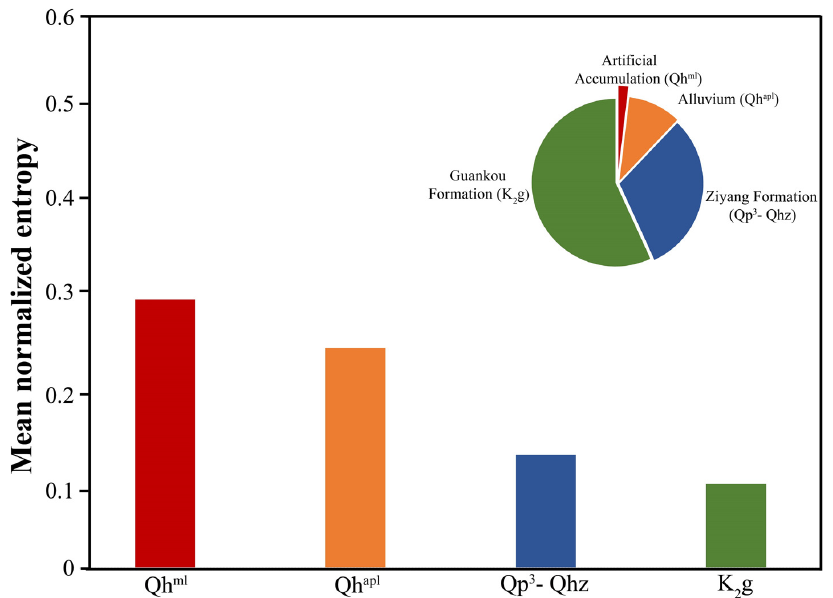
Figure 7. Average normalized entropy and statistics of cell number of each stratigraphic class. The bar chart shows the average normalized entropy of each stratigraphic class. The pie chart on the upper right represents the percentage of cell numbers of each stratigraphic class in the reconstruction space.